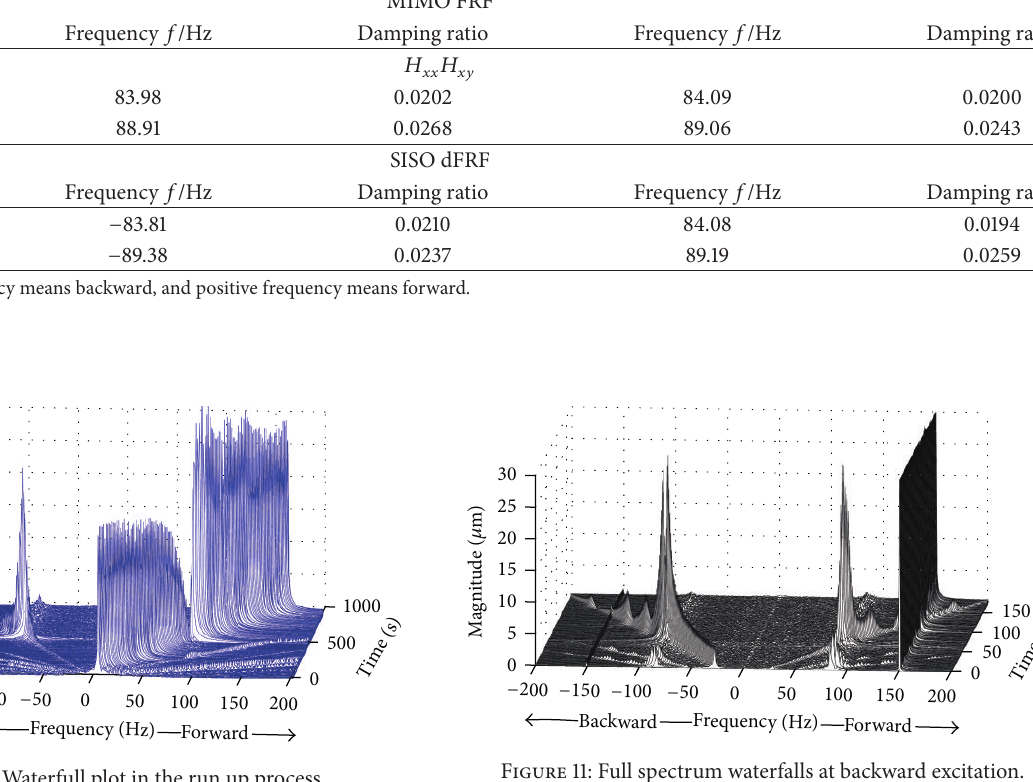
Figure 9: Waterfull plot in the run up process.